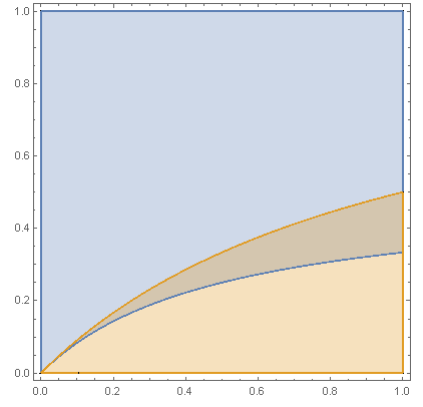
Figure 3. The concavity condition (12) holds for profiles p with ( p k , p k + 1 ) squeezed between the